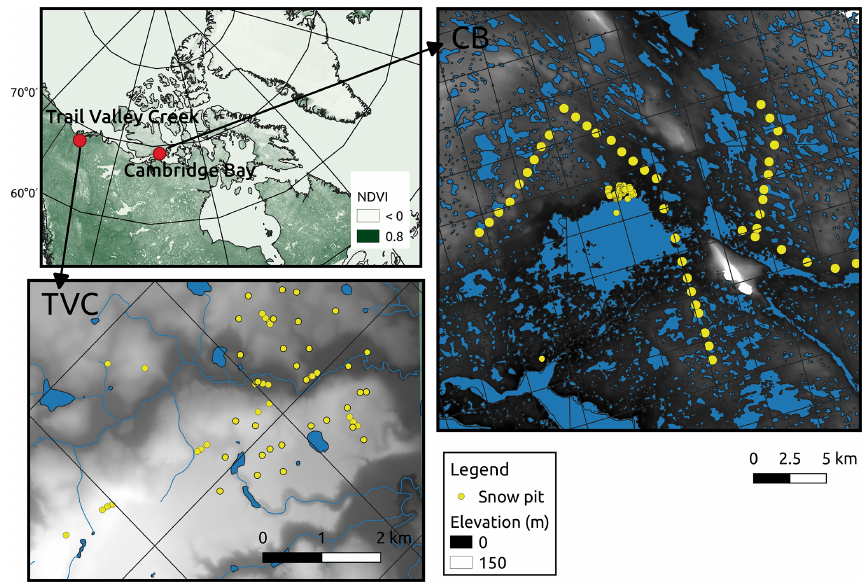
Figure 1. Locations of study areas in the Canadian Arctic, Cambridge Bay and Trail Valley Creek site. Grid shown is the enhanced 3.125km EASE-Grid 2.0 (Brodzik et al., 2018) used for satellite data. The ArcticDEM used to show elevation has a 2m resolution (Porter et al., 2018) derived from stereo high-resolution visible imagery for the entire Arctic domain, which is freely available. Table 1. Summary of the number of snow depth measurements (magnaprobe and RPAS) and snow pit sites per year. The availability of SSA and density measurements across sites and years is also noted ( × ). See Table 2 for full dates. Site Date Depth